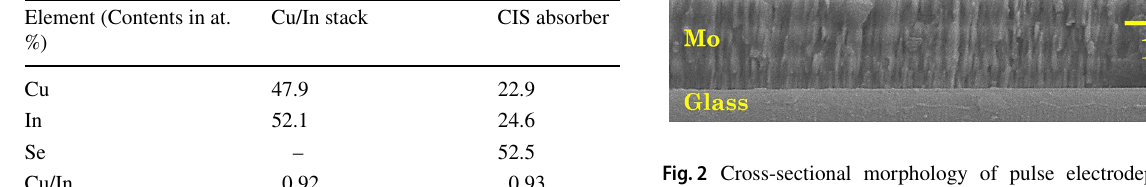
Fig. 2 Cross-sectional morphology of pulse electrodeposited sele- nized CIS